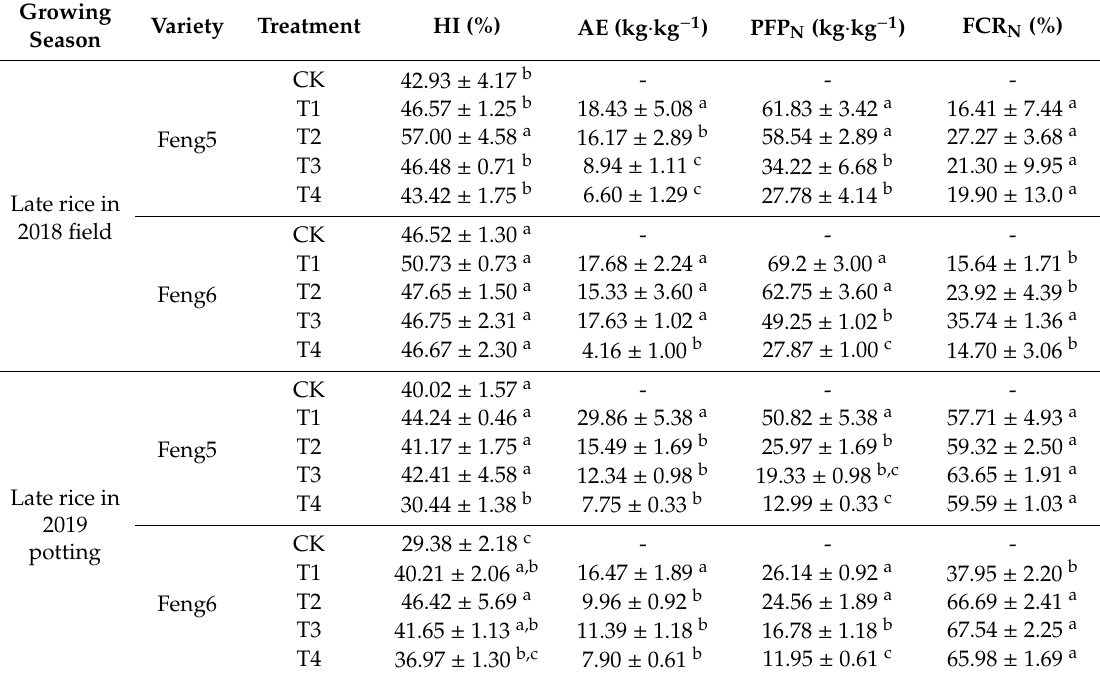
Table 7. Changes in nitrogen efficiency in giant rice under nitrogen treatment.